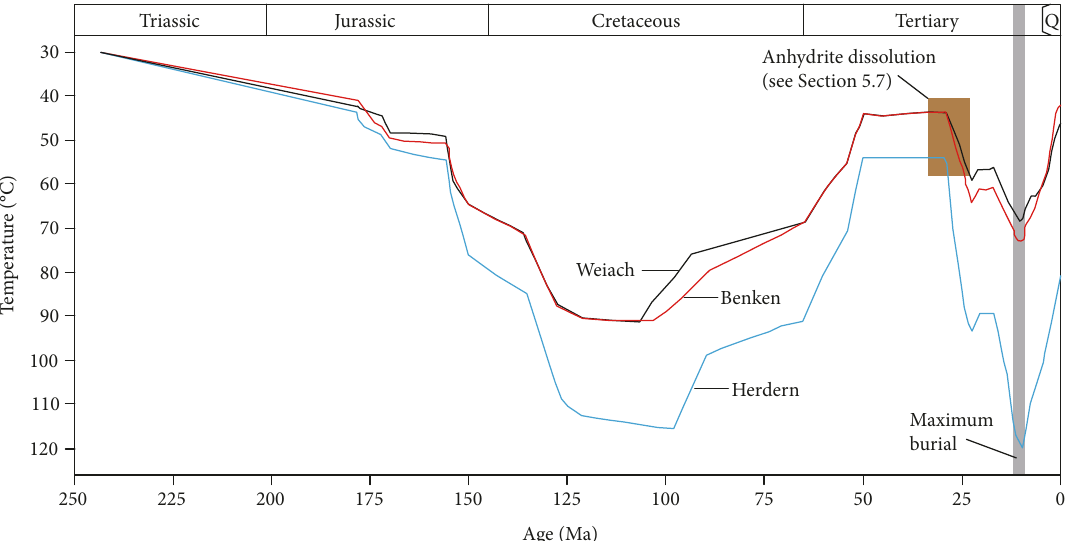
Figure 2: Reconstructed temperature evolution at the top of the Trigonodus Dolomit in the NE part of the SMB, based on data in Nagra